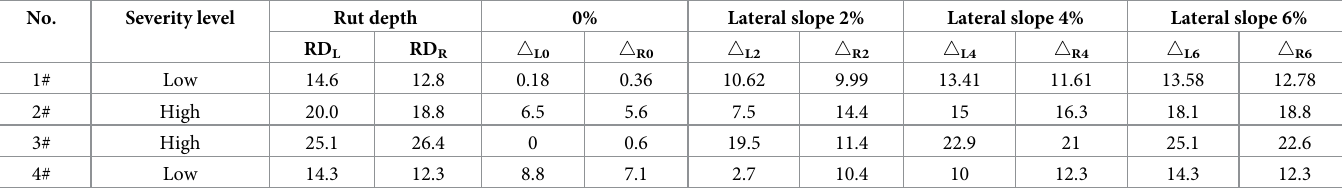
Table 4. Comparison of rut depth and water-filled rut depth. (unit: mm). No.